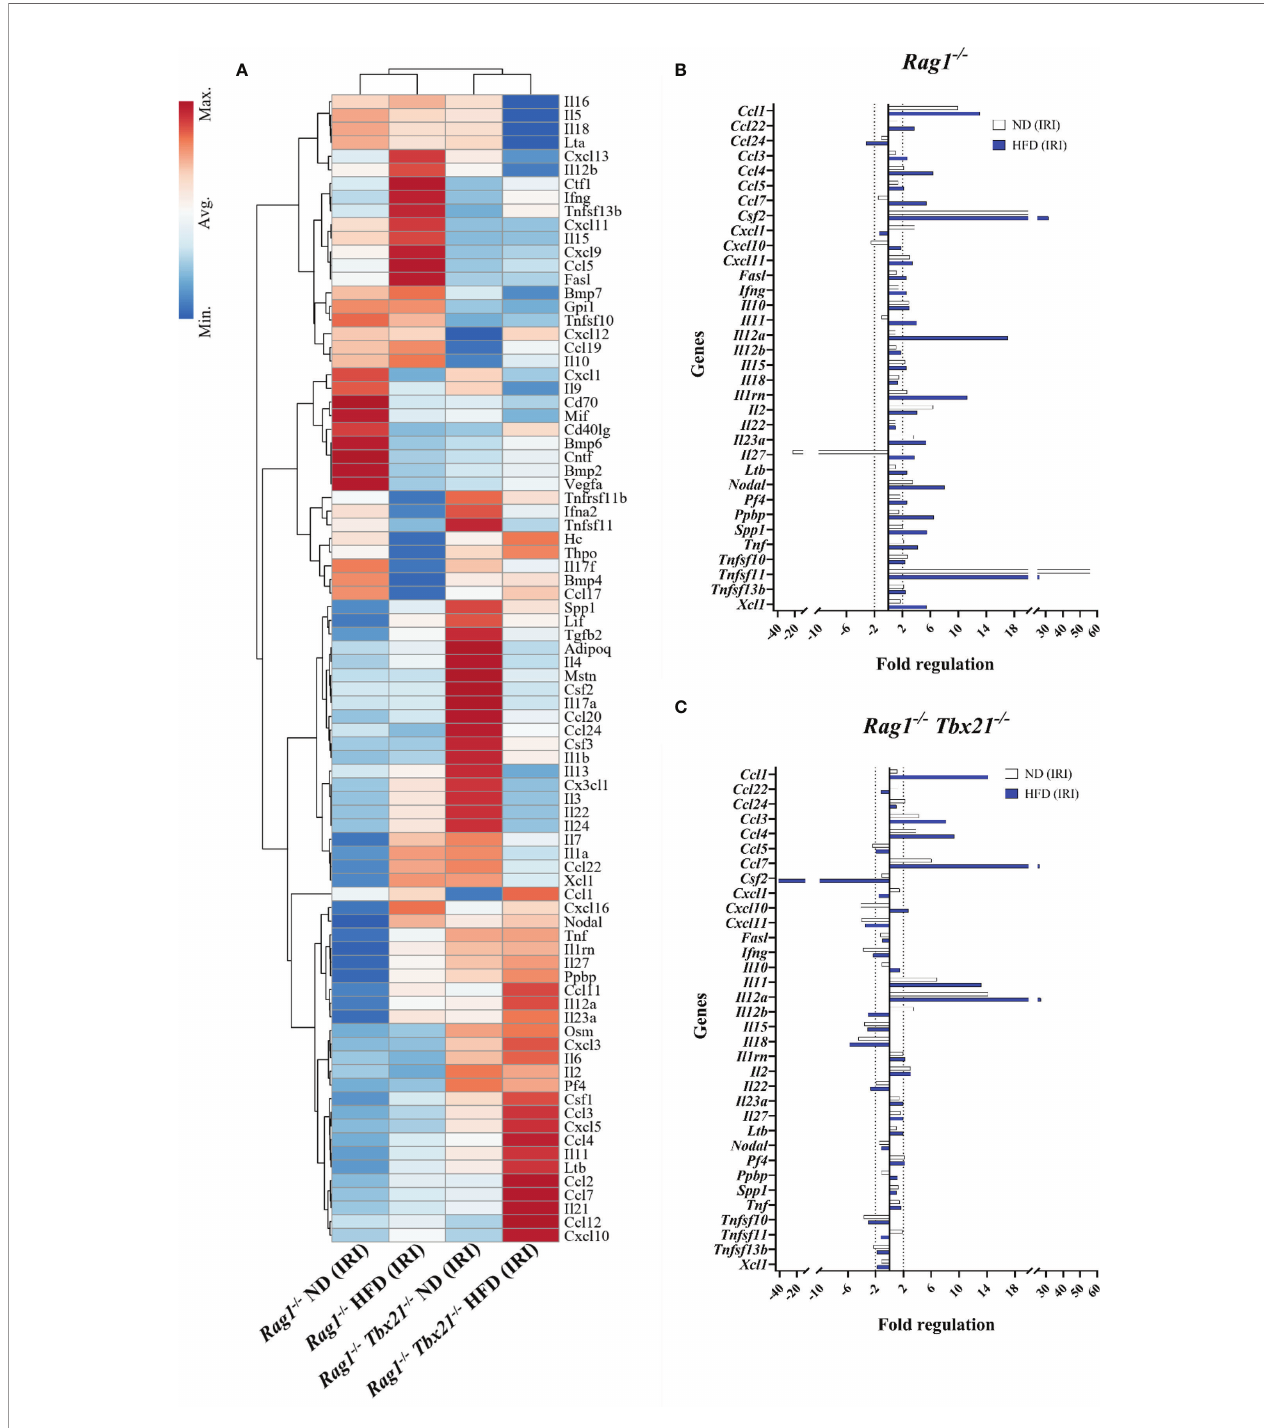
FIGURE 6 | Cytokine and chemokine gene expression array for mice liver IRI. (A) Clustergram represents unsupervised hierarchical clustering analysis of RT 2 qPCR pro fi ler array for ND Rag1 − / − HFD Rag1 − / − , ND Rag1-Tbet DKO, and HFD Rag1-Tbet DKO pooled, post-IRI mice liver tissues. Comparative fold regulation analysis of post-IRI cytokines and chemokines with at least 2-fold or more up-and down-regulation between (B) ND and HFD Rag1 − / − and (C) ND and HFD Rag1-Tbet DKO mice liver tissues relative to the respective ND non-IRI control. Dotted vertical lines mark up-and down-regulation of the gene expression. All data are represented as a gene expression of at least three pooled bulk mouse liver